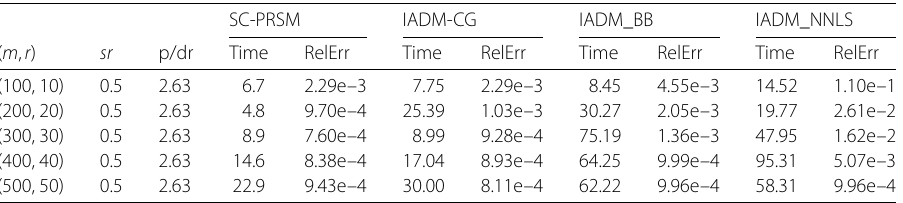
Table 2 SC-PRSM, IADM-CG, IADM_BB, IADM_NNLS for solving the hard nuclear norm